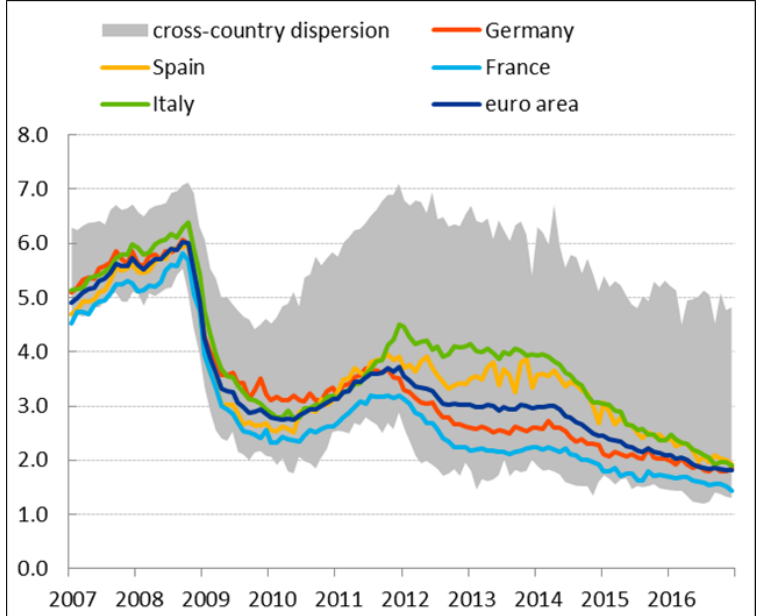
Figure 4. Composite bank interest rates for new loans to non-financial corporations (percentages per annum). Source: ECB. Latest observation: December 2016. Note: The composite cost of bank lending combines short- and long-term rates on new loans using a 24-month moving average of new business volumes as weights. The cross-country dispersion displays the minimum and maximum range over a fixed sample of 12 euro area countries.